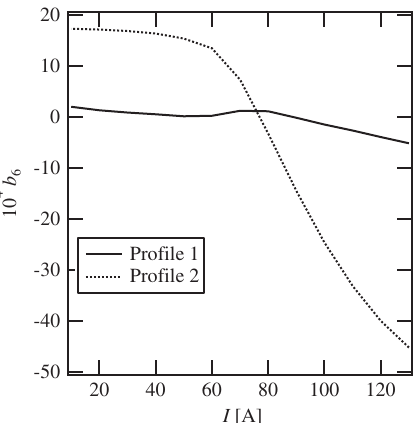
FIG. 9. Pole shapes obtained with different settings of the optimization algorithm. The dashed arc indicates the 7 mm radius GFR.